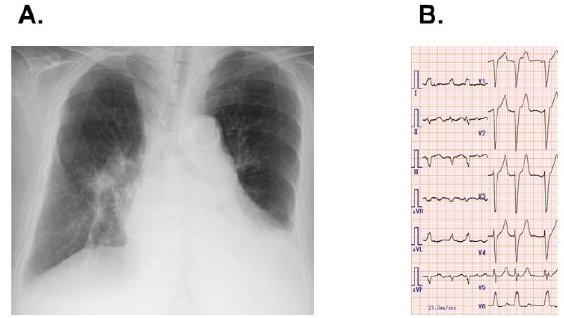
Figure 1. Chest X-ray ( A ) and electrocardiogram ( B ) on admission.